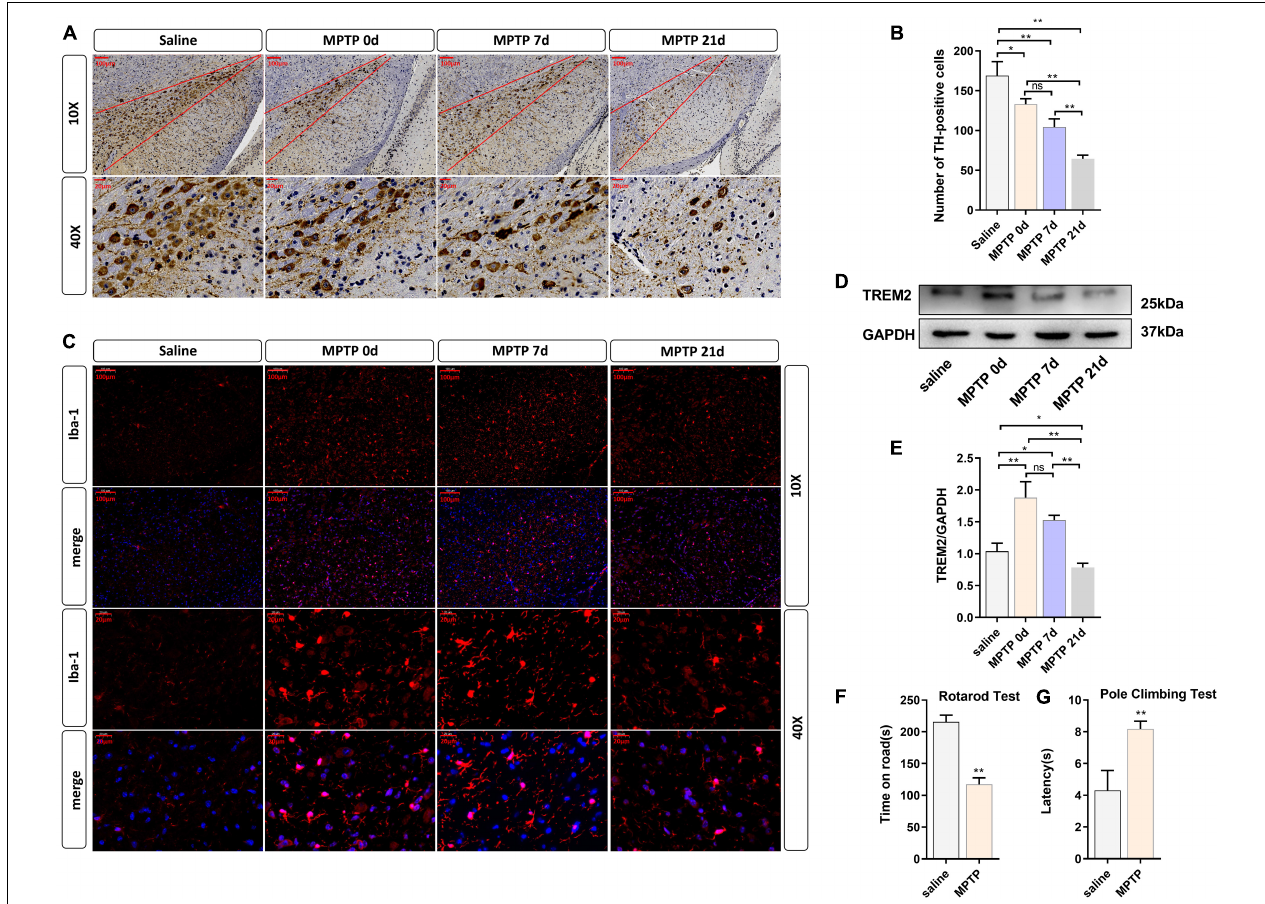
FIGURE 4 | TREM2 expression and microglial activity were observed in the SNpc of mice treated with MPTP. The mice were intraperitoneally injected with MPTP-HCI once a day for 5 days, and the control group was injected with normal saline. Then, the mice were sacrificed by decapitation at different time points (0, 7, or 21 days) after the last injection of MPTP, and the midbrain tissue was collected. 0 day (immediately after the last MPTP injection). (A) Immunostaining of tyrosine hydroxylase (TH)-positive neurons in the SNPC is shown ( n = 3/group). Scale bar: 100 µ m and 20 µ m. (B) The number of TH cells in the SNpc (the area between two red lines) were manually counted ( F = 48.73). (C) Immunofluorescence images confirmed the expression of Iba-1 ( n = 3/group). Red: anti-Iba1 (antibody labeling microglia). Scale bar: 100 µ m and 20 µ m. (D) After MPTP injection, the expression level of TREM2 protein was detected by WB ( n = 3/group). (E) The expression level of TREM2 protein was analyzed by quantitative analysis of protein ( F = 35.52). All the quantitative analysis of protein was done by Image J to calculate the gray value. (F,G) The pole-climbing test and rotarod test for bradykinesia were performed on 7th day after the last MPTP injection ( n = 12/group). Data are shown as the mean ± SE. The fold change is significant where * P < 0.05, ** P < 0.01. n = number of